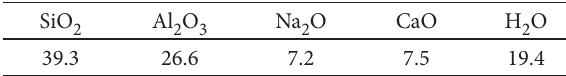
Table 2. Chemical composition of zeolite